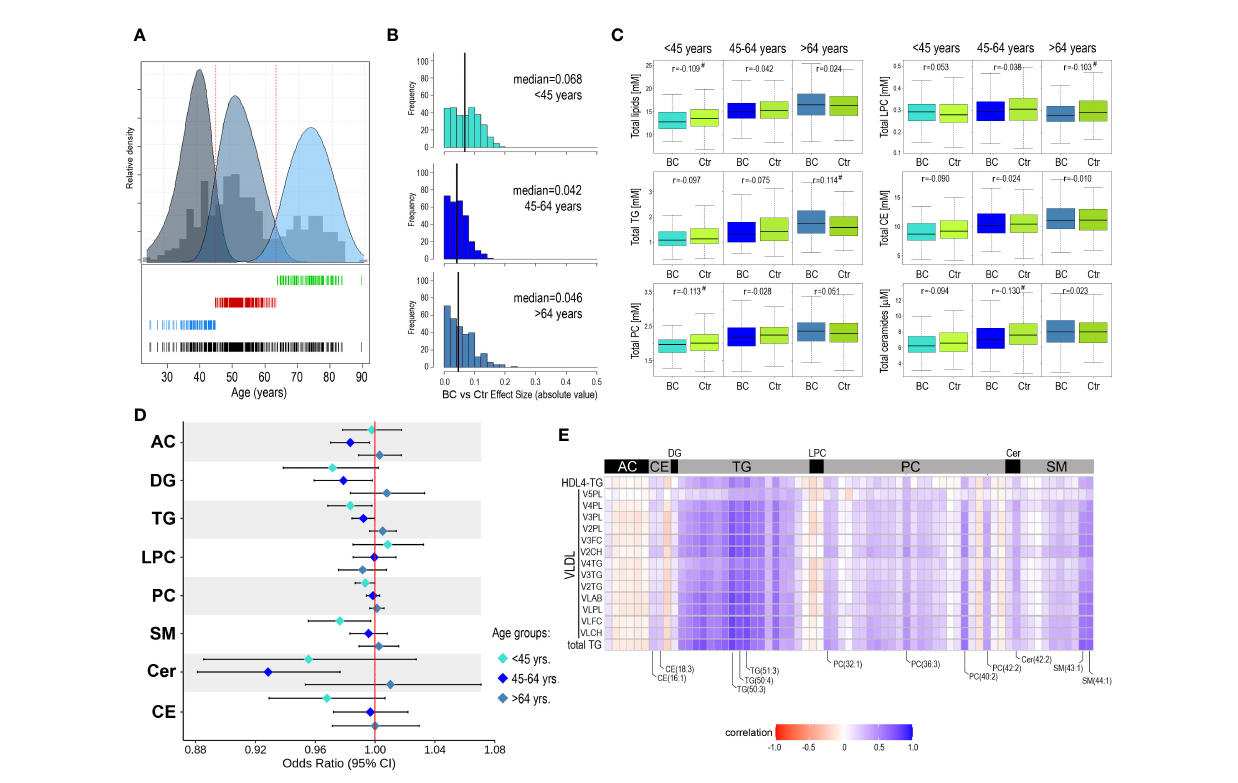
FIGURE 2 Metabolome pro fi les in serum of younger and older participants of the HUNT2 study. (A) – Distribution of age of participants selected for the analysis (all participants together); three subgroups were identi fi ed by the components of the Gaussian mixture model: <45-year-old, 45-64-year- old, and >64-year-old (bottom). (B) – Distribution of metabolites that showed the increased signi fi cance of differences between BC cases and controls in three age-de fi ned subgroups of participants (vertical lines represent the median of effect sizes). (C) - Differences in aggregated concentration of different classes of lipids between BC cases and controls (in three age-de fi ned subgroups of participants); hashtags marked at least a small effect size. (D) – Odds ratios (and 95% con fi dence intervals) for the association between increased concentration of selected metabolites and risk of breast cancer during follow-up in age-de fi ned subgroups. (E) – The correlation between the concentration of serum lipids measured by HR- MS (current study) and levels of NMR-measured lipoprotein particles (Debik et al., 2021) in the subgroup of younger participants (<45-year-old); showed lipids with at least a small effect size of differences between BC and Ctr groups (r>0.1) and lipoprotein particles with adjusted p-value <0.05 (AC – acylcarnitines, DG – diglycerides, CE – cholesteryl esters, Cer – ceramides, FC – free cholesterol, LPC – lysophosphatidylcholines, PC